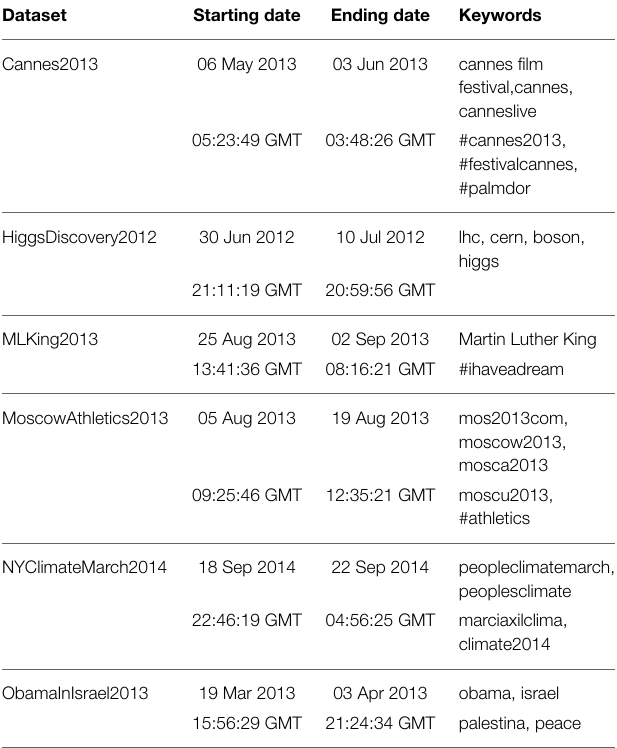
TABLE 1 | Information about events used in this work. TABLE 2 | Number of nodes and edges of the network corresponding to each event considered in this